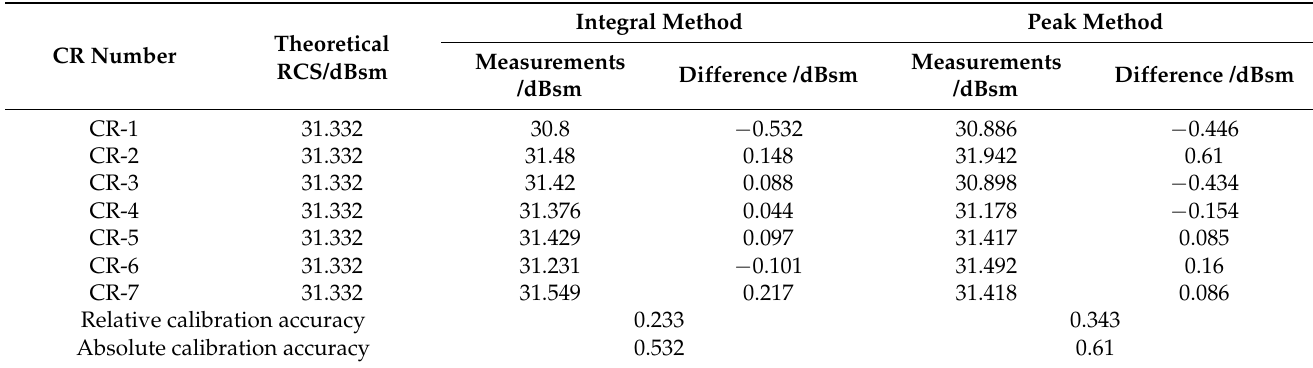
Table 8. Each point target RCS and accuracy analysis for UFS mode data on 12